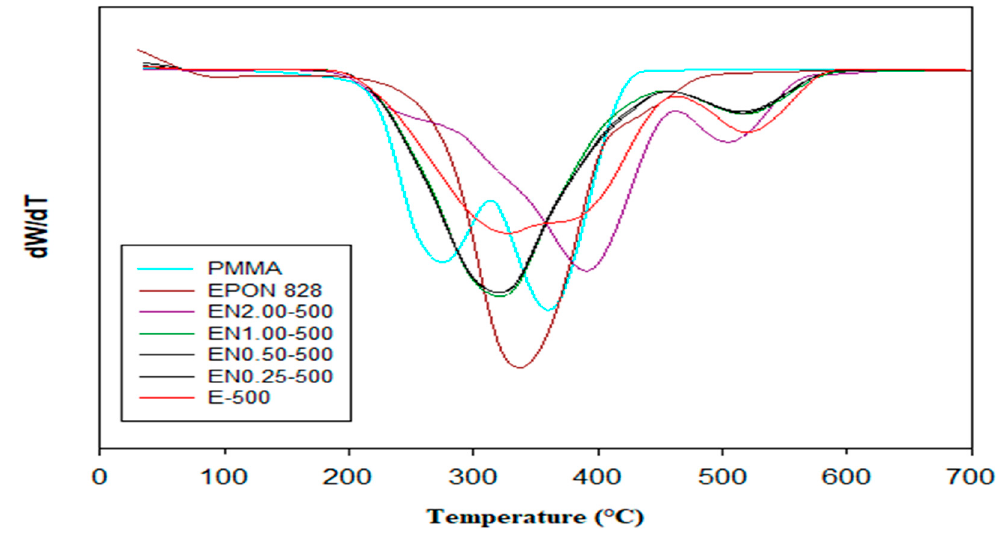
Figure 5. Derivative thermogravimetric (DTG) thermograms of epoxy, PMMA, and PMMA microcapsules containing epoxy/CNT mixtures, under a nitrogen atmosphere at a heating rate of 10 °C min − 1 .